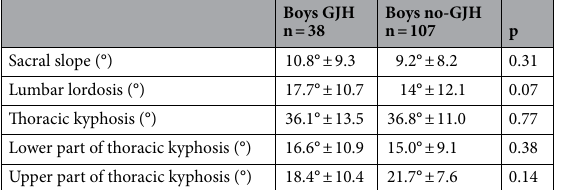
Table 4. Comparison of the sagittal curvatures of the spine in a relaxed sitting position between boys with (GJH) and without (no-GJH) generalized joint